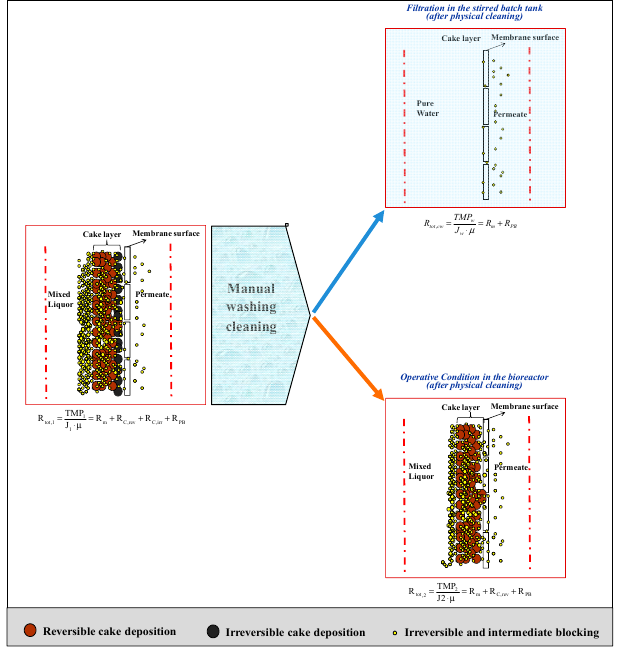
Membranes 2019 , 9 , x FOR PEER REVIEW 19 of 29